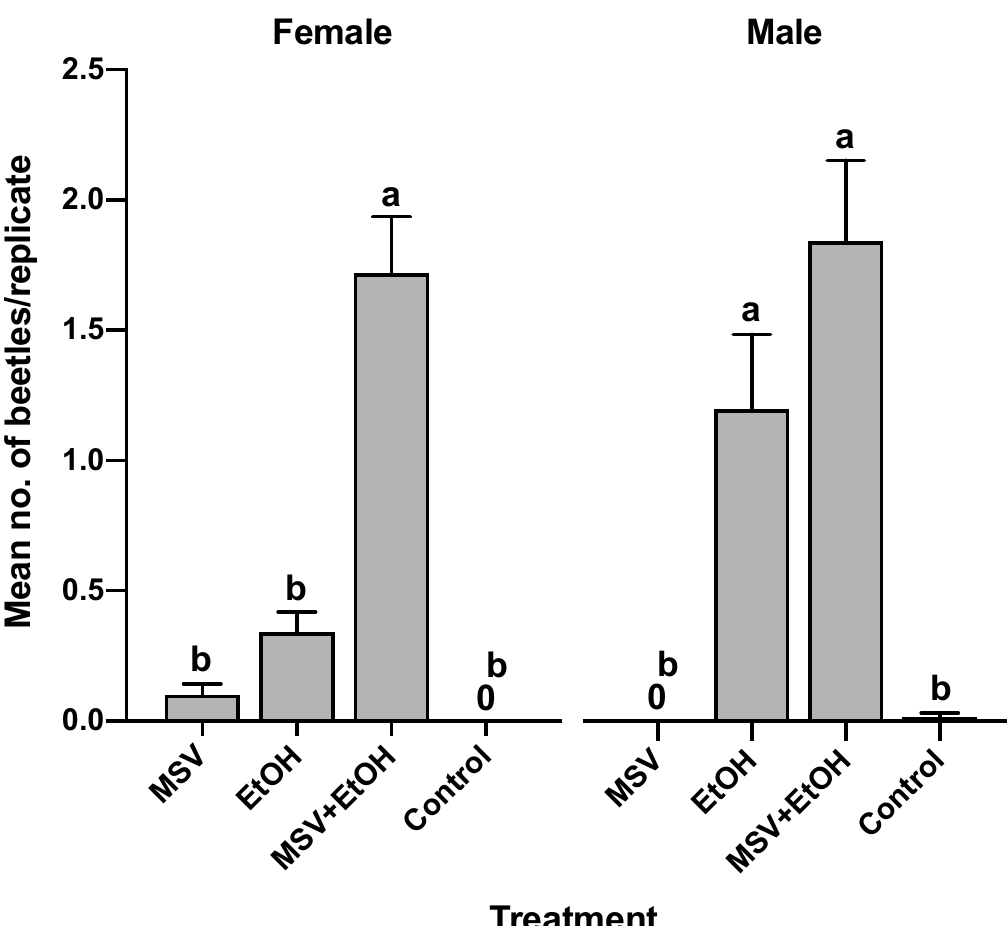
Figure 4. Mean ( ± SE) numbers of adult females and males of Euplatypus parallelus caught with traps containing synthetic male-specific volatile compounds in combination or not with ethanol. Treatment abbreviations: MSV = male-specific volatiles, i.e., blend of 3-methyl-1-butanol, 1-hexanol, hexyl acetate, 1-octanol, and geraniol in the same ratio produced by conspecific males; EtOH = 99.5% ethanol; control = neat isopropanol. Type of attractant lure significantly affected the trap catch of females (Q 3, 200 = 101.4, p < 0.0001) and males (Q 3, 252 = 133.6, p < 0.0001). Means followed by same letter within a panel are not significantly different according to the Ryan-Einot-Gabriel-Welsch Q multiple range test at 5% probability.